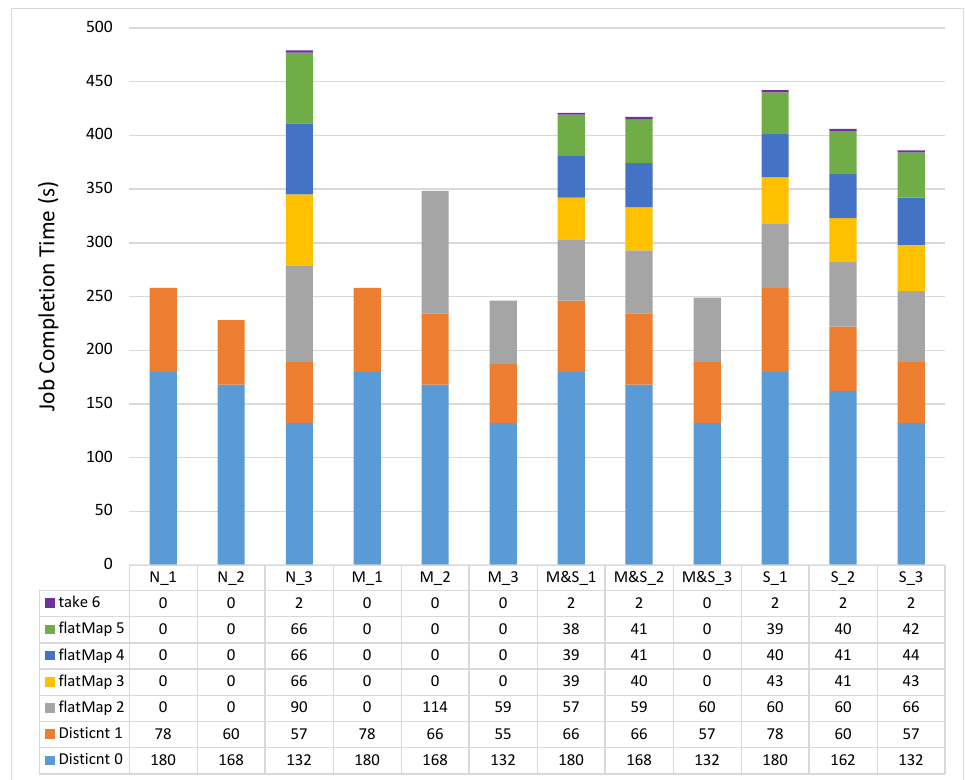
Figure 5. The PageRank job execution time for 1 GB